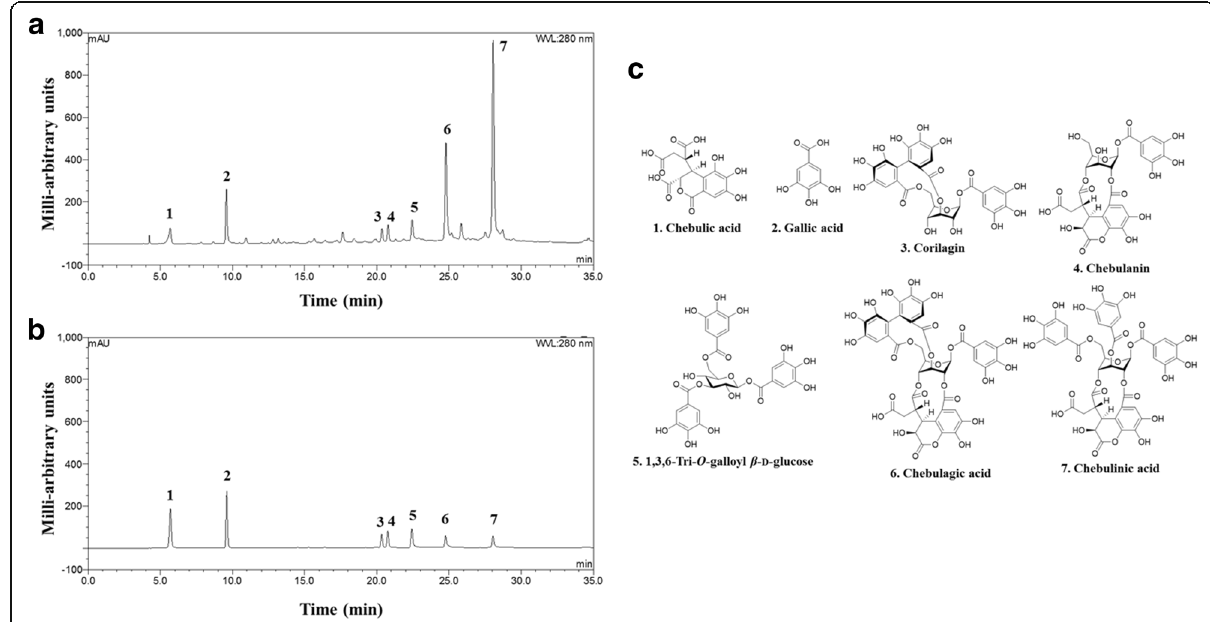
Fig. 6 Representative HPLC-UV chromatogram . a HPLC-UV chromatogram of TCE. b HPLC-UV chromatogram of seven standard compounds in the mixed solution. c Chemical structures of the seven main compounds in TCE